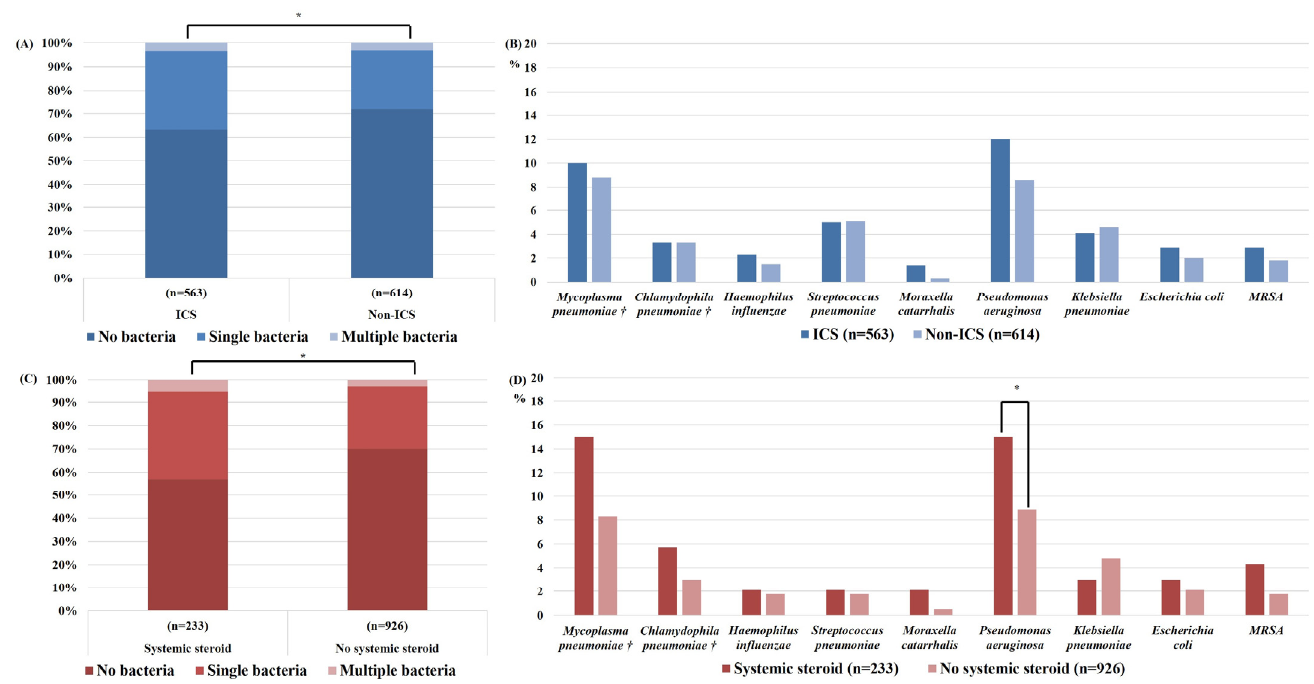
Figure 2. Bacterial detection rates during acute exacerbations of chronic obstructive pulmonary disease, with or without ICS or systemic steroid used within the previous 6 months: ( A ) overall bacterial detection rate, ( B ) detection rate for each bacterial species with or without ICS use, ( C ) overall bacterial detection rate, and ( D ) detection rate for each bacterial species with or without systemic steroid use. * p < 0.05, † Bacteria were detected in respiratory specimens via polymerase chain reaction, or in serum via immunoglobulin M measurement (n = 602). ICS, inhaled corticosteroid; MRSA, methicillin-resistant Staphylococcus aureus .